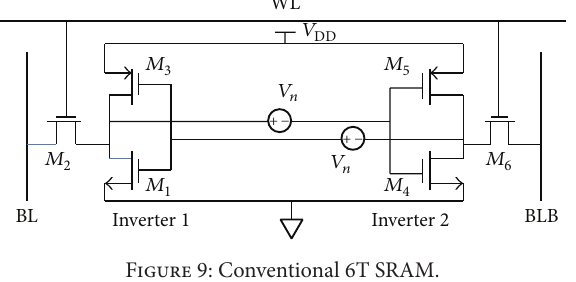
Figure 9: Conventional 6T SRAM.